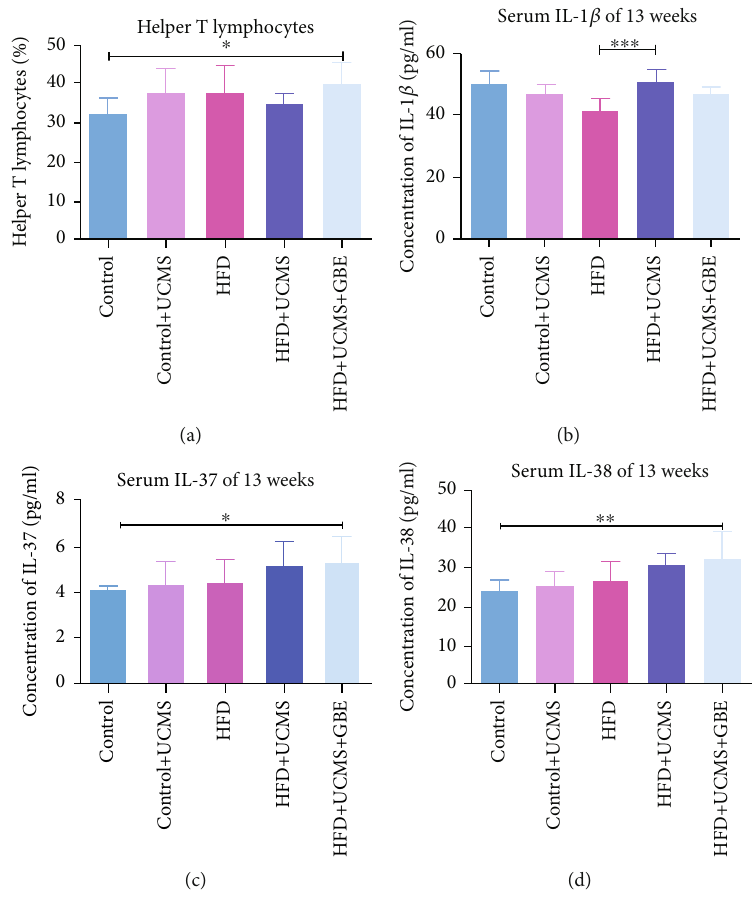
Figure 4: Peripheral immune imbalance. (a) The fl ow cytometry of TH cells for the di ff erent treatment groups at 13 weeks; (b – d) comparisons of serum in fl ammatory cytokines IL-1 β , IL-37, and IL-38. Helper T lymphocytes: TH cells. n = 5 rats per group; ∗ P < 0 : 05 ; ∗∗ P < 0 : 01 ; ∗∗∗ P < 0 : 001